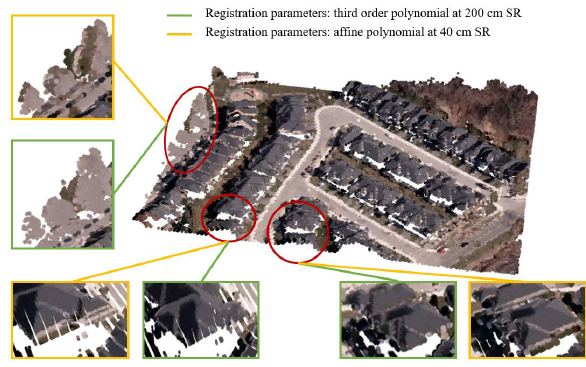
Figure 13. Qualitative